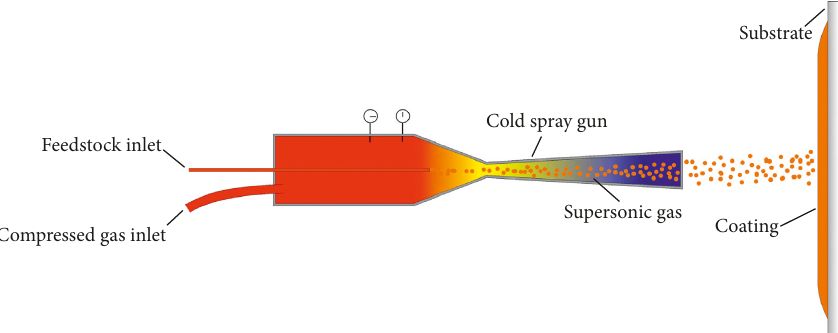
Figure 1: Schematic of the cold spray process.